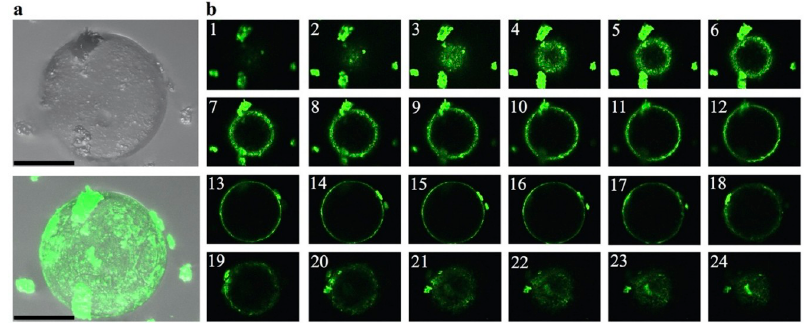
Fig 3. ThT-positive, TDP-43’s PrLD fibrils emerge from protein droplets. (a) Visualization of a ThT-stained droplet from the 110 μ M aggregated sample by confocal microscopy (top: transmitted light image, bottom: overlay with the ThT fluorescent image; scale bar: 50 μ m). The nonhomogeneous staining suggests that fibril assembly occurs on droplet surface, and not its interior. Scale bar is 50 μ m. (b) Sections of the droplet evince that the droplet interior is devoid of fibrils, whereas ThT fluorescence maps the droplet surface, at the droplet/solvent interface boundaries, and suggests detachment of fibrils once a certain size is reached. Images 1–24 are selected sections from a collection of 42 slices passing from pole to equator to pole that illustrate the distribution of ThT-positive aggregates across the droplet surface. PrLD, prion-like domain; TDP-43, Transactive response DNA-binding Protein of 43 kDa; ThT, Thioflavin T.